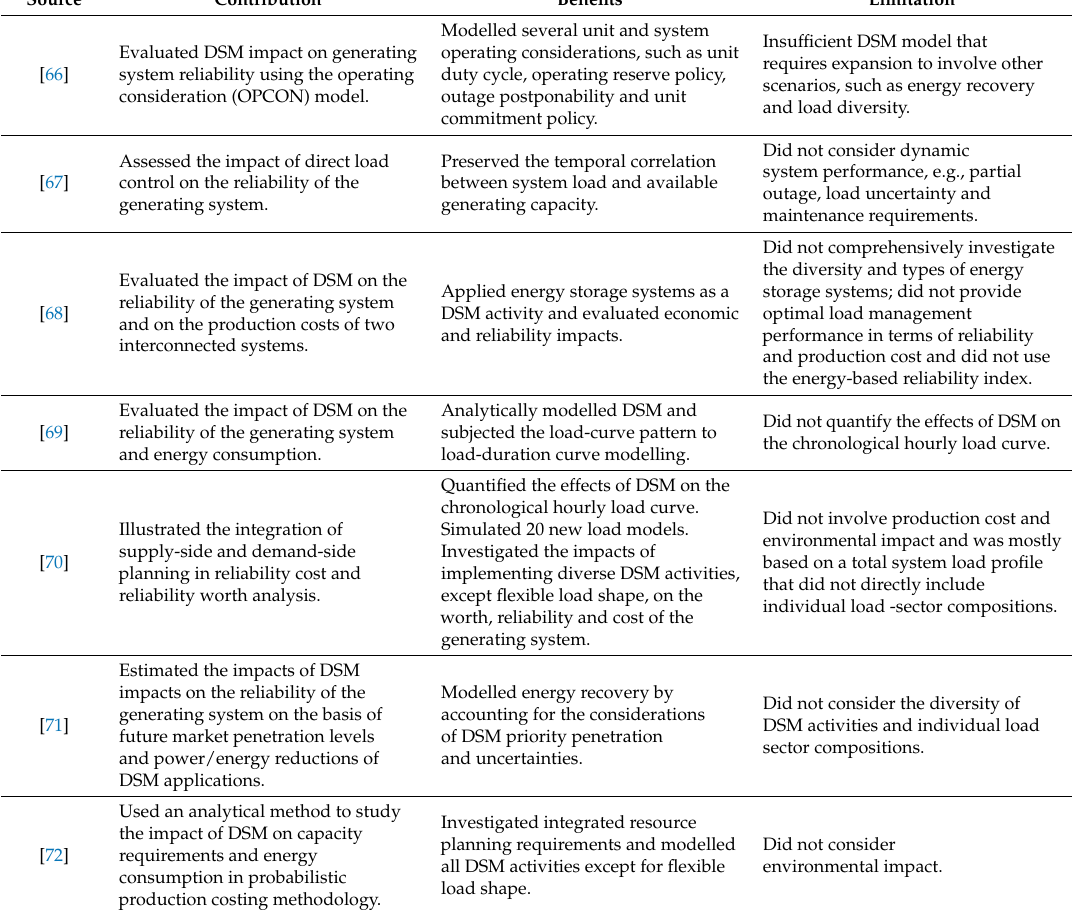
Table 1. Comparison of notable works on the impacts of DSM on